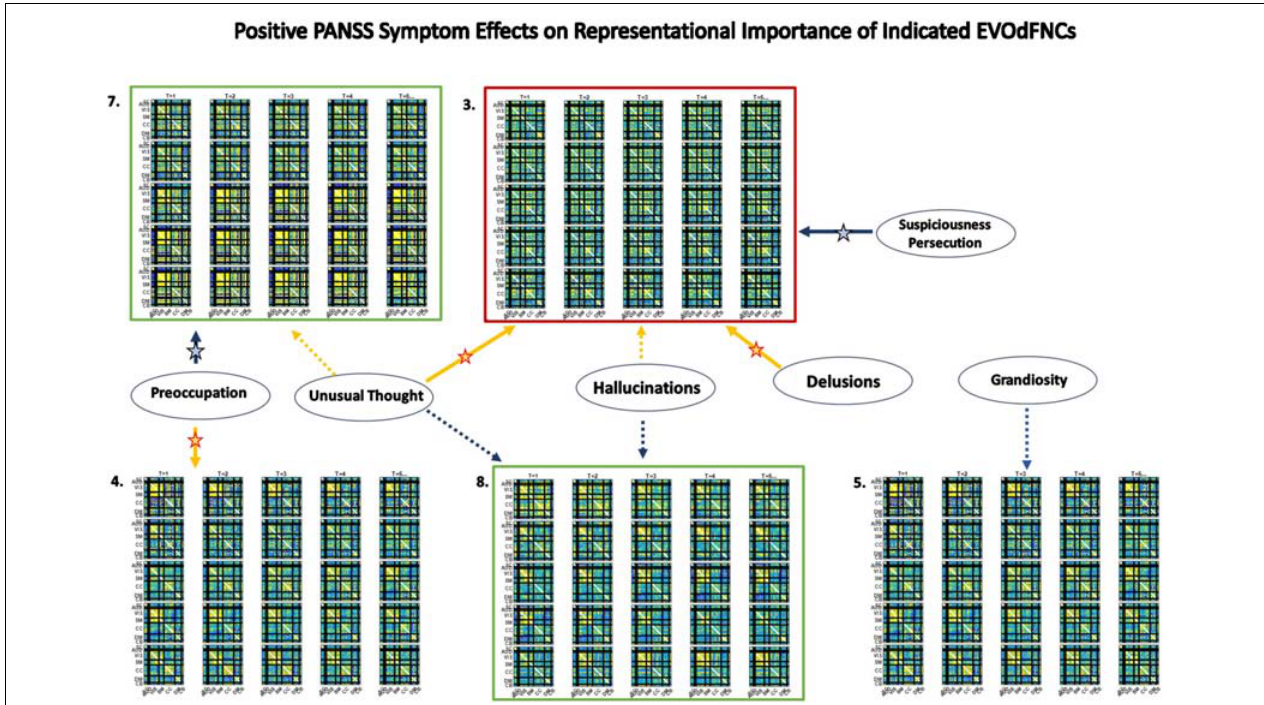
FIGURE 12 | Significant positive symptom effects on the representational importance of EVOdFNCs in high-dimensional dFNC dynamics. Thick arrows with stars indicate effects that are significant after correction for multiple comparisons; thin dashed arrows indicate effects that are significant with p < 0 . 05, but not after correction for multiple comparisons. Yellow lines denote positive effects. Blue lines denote negative effects. EVOdFNC 3, the low-contrast, low-dynamism DMNneg patterned state is a locus of positive symptom effects: RI elevated by Hallucinations, Delusions and Unusual thought, and suppressed by Suspiciousness/Persecution. EVOdFNC 7, dynamically changing from a low-contrast DMNneg pattern to an AVSM-dominant hyperconnected pattern is more important in HCs than SZs, but among SZs with high levels of Preoccupation its importance is further significantly suppressed and elevated in those with high levels of Unusual Thought. Note that positive symptoms exhibit no significant ( p < 0.05, uncorrected) effects on the occupancy rates of the